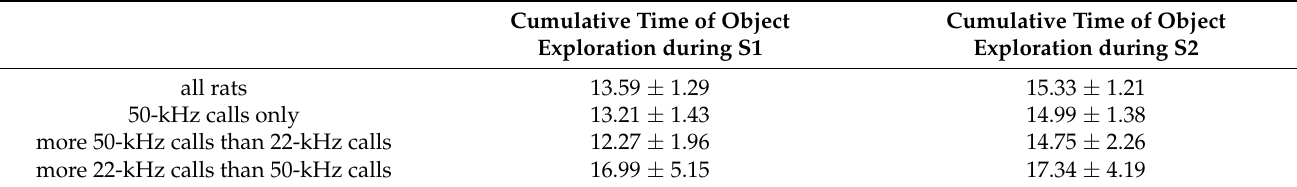
Table 1. Cumulative times of object exploration during sessions 1 and 2 of the novel object recognition test in rats grouped according to the prevalent type of ultrasonic vocalizations emitted in response to tickling. Exploration times are reported as the average number of seconds ± S.E.M. S1 = session 1; S2 = session 2. Cumulative Time of Object Cumulative Time of Object Exploration during S1 Exploration during S2